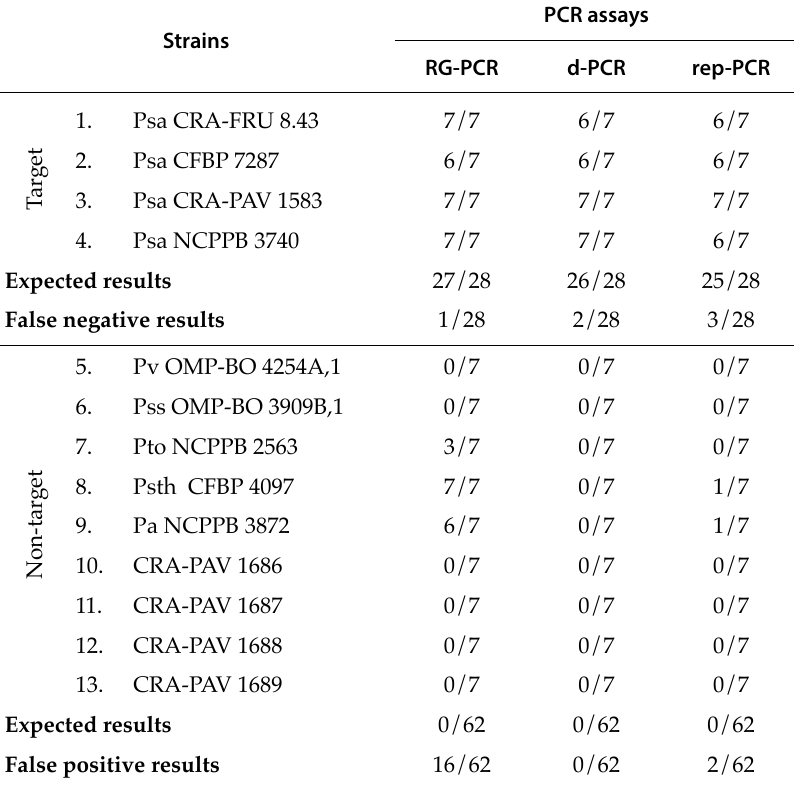
Table 5. Amplification results obtained by RG-PCR (Rees-George et al ., 2010), d-PCR (Gallelli et al ., 2011) and rep-PCR (Lou- ws et al ., 1994) on target and non-target bacterial cultures reported in Table 1 from the seven laboratories participants in the comparative test. For target strains (1‒4) the expected results for each method were: 7/7 (seven positive results obtained from each laboratory); for non-target strains (5‒13) the expect results for each method were: 0/7 (null positive results ob- tained from the seven laboratories). Psa = Pseudomonas syringae pv. actinidiae ; Pv = P. viridiflava ; Pss = P. s. pv. syringae ;